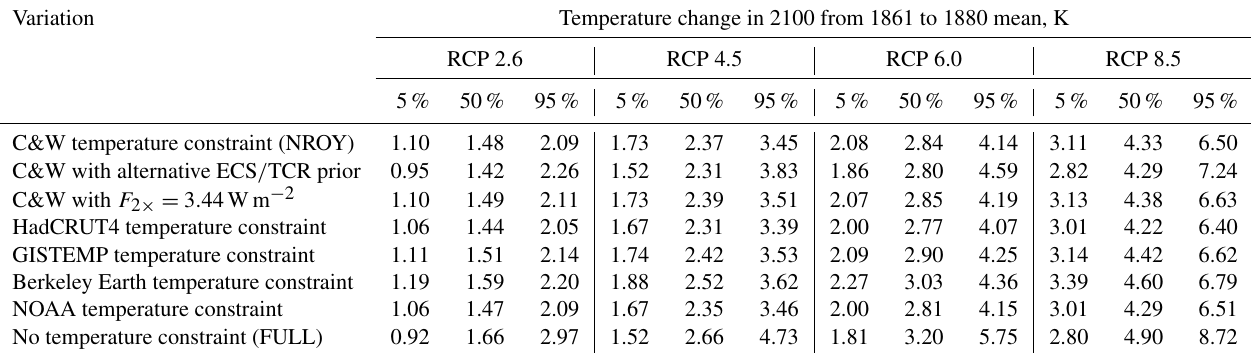
Table 9. Sensitivity in the 2100 temperature change in RCP scenarios to variations in the underlying assumptions in the FAIR large ensemble. Variation Temperature change in 2100 from 1861 to 1880 mean,